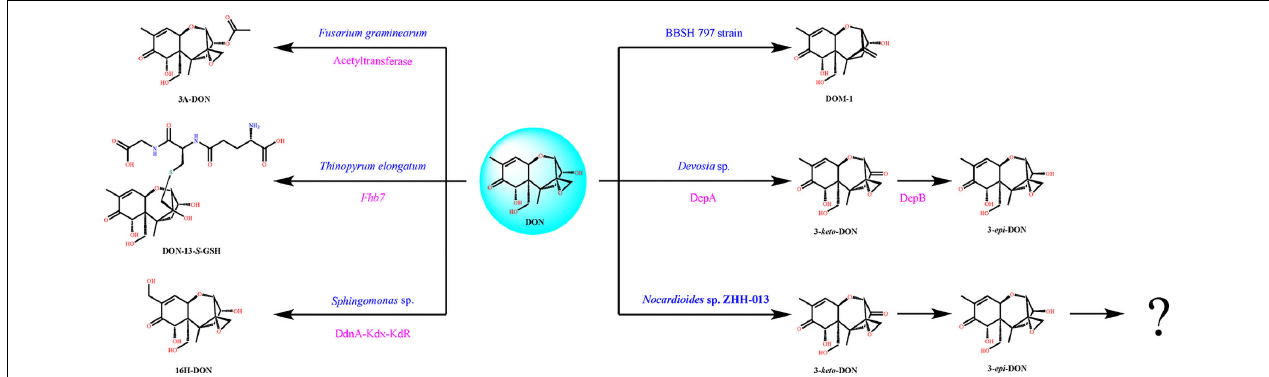
FIGURE 6 | Typical DON degradation pathways of different microorganisms including Nocardioides sp. ZHH-013. The blue characters denote microorganism name, and the rose red characters denote identified gene or enzyme.